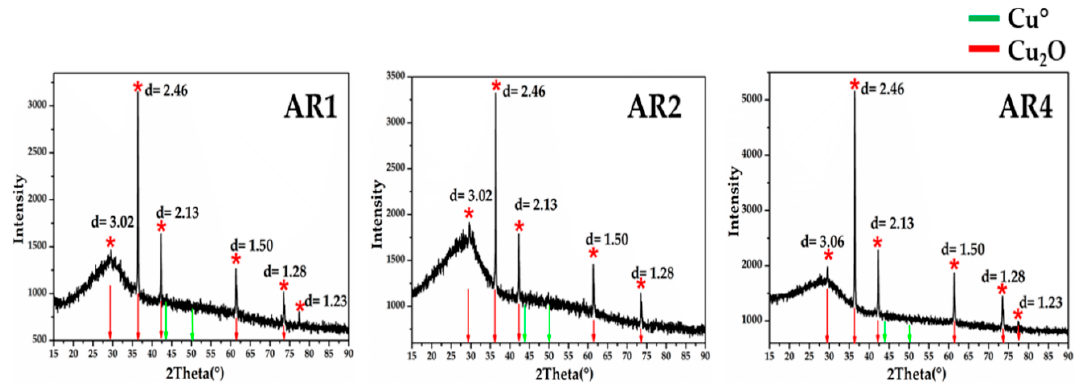
Figure 22 . X-ray diffraction for the three orange samples of Gr-5 group. The diffractograms showed the typical peaks of cuprite cubic crystals. No metallic copper crystals were detected.